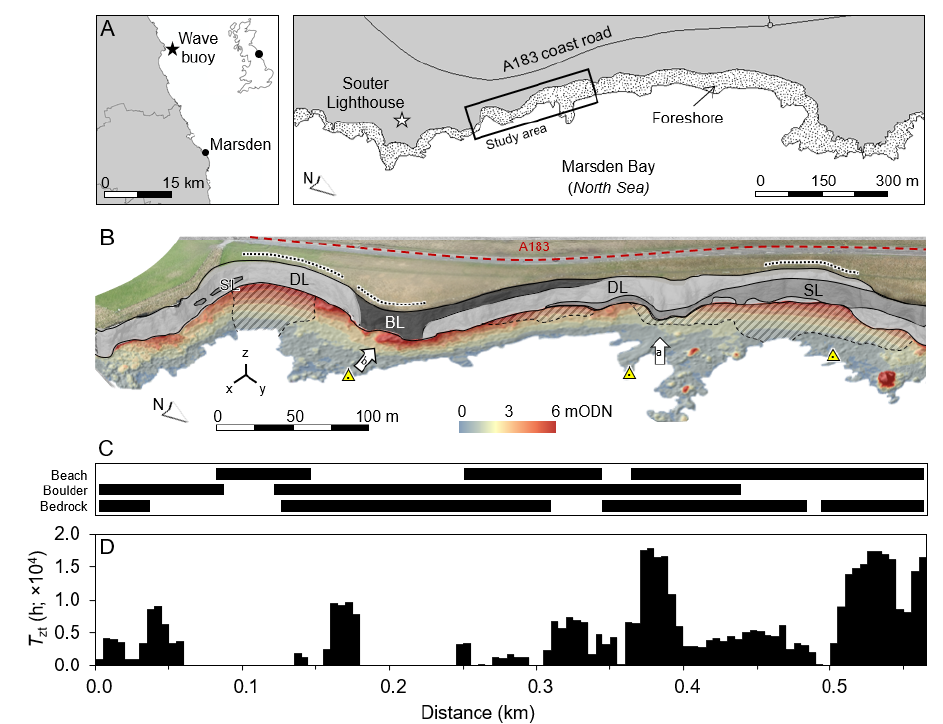
Figure 1. ( A ): Study site location on the north-east coast of England. ( B ): Oblique view of a photogrammetrically derived 3D model of the Marsden Bay study area. The cliff face is shaded according to the dominant lithology, where DL = dolomitic limestone, SL = secondary limestone, BL = brecciated limestone. Blue to red shading indicates foreshore height (m) relative to Ordnance Datum Newlyn (ODN). Grey hatching shows the extent of beach deposits; remaining foreshore comprises exposed bedrock or boulder aprons (clasts > 1 m 3 ). Yellow triangles show reoccupied terrestrial laser scanner (TLS) survey positions. White arrows show the camera position and orientation for the field photographs shown in Figure 2. The location of the A183 coastal road is also shown for reference. ( C ): Cross-shore foreshore unit classification. ( D ): Cross-shore cumulative tidal inundation ( T zt ) of the cliff toe for the period 21 February 2015–3 March 2017. Data are presented in 5 m cliff line bins. Distance axis in D applies to all panels.